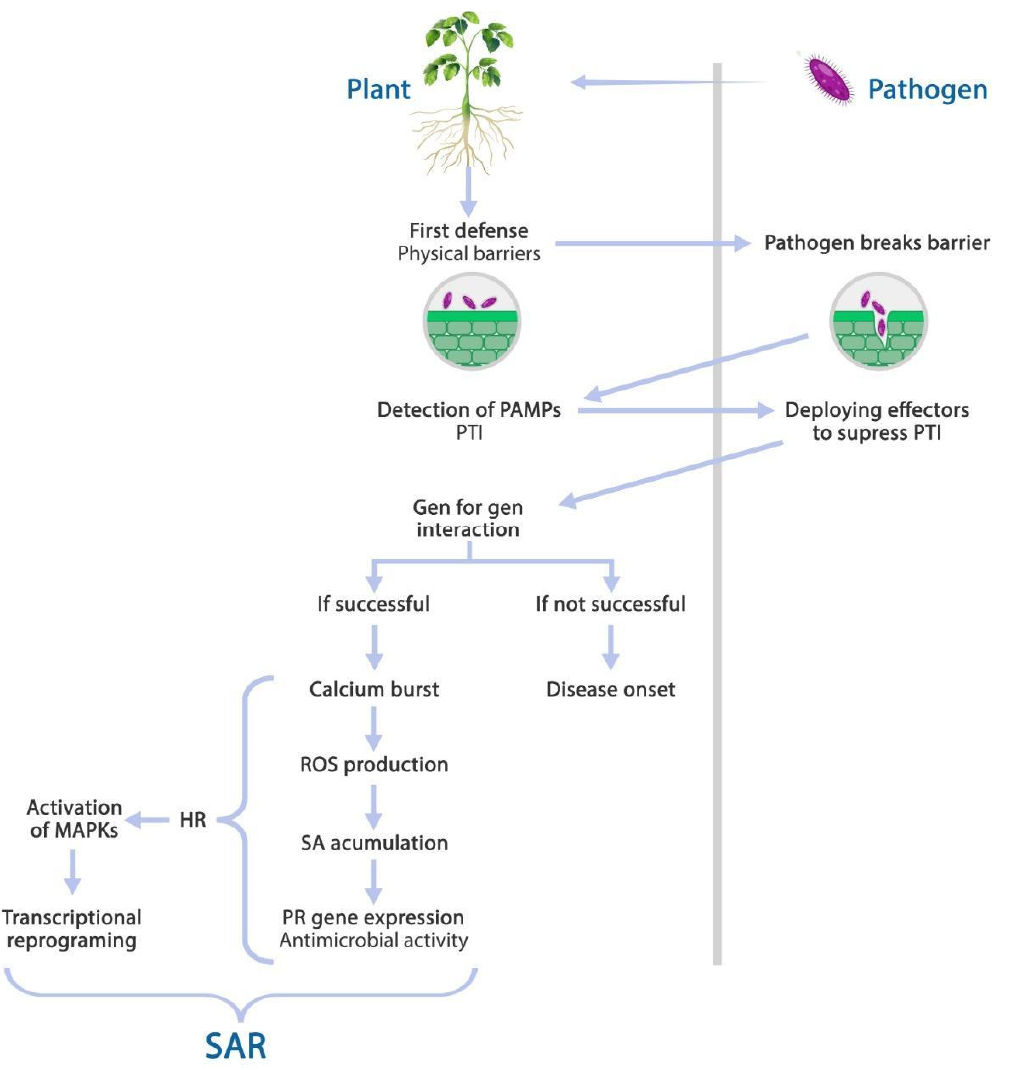
Figure 2. Activation of the systemic acquired resistance, through the interaction of plants and pathogens.